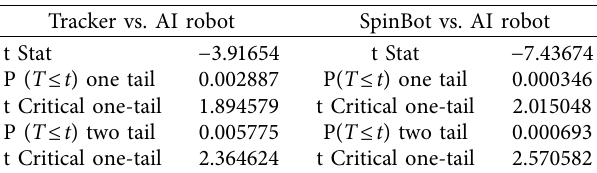
Table 2: T-test results between the AI robot and Tracker and SpinBot robots. Tracker vs. AI